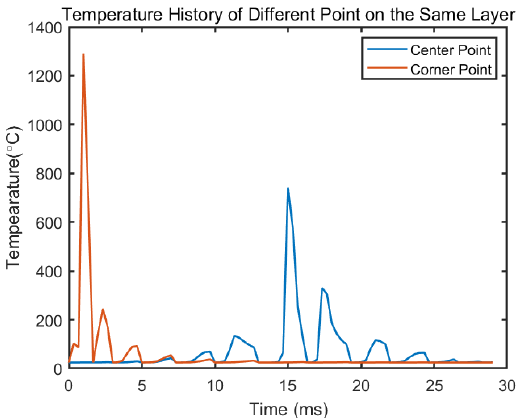
Figure 12. Temperature history of different point on the fifth layer on a 4 mm 2 square island with the same process parameter.